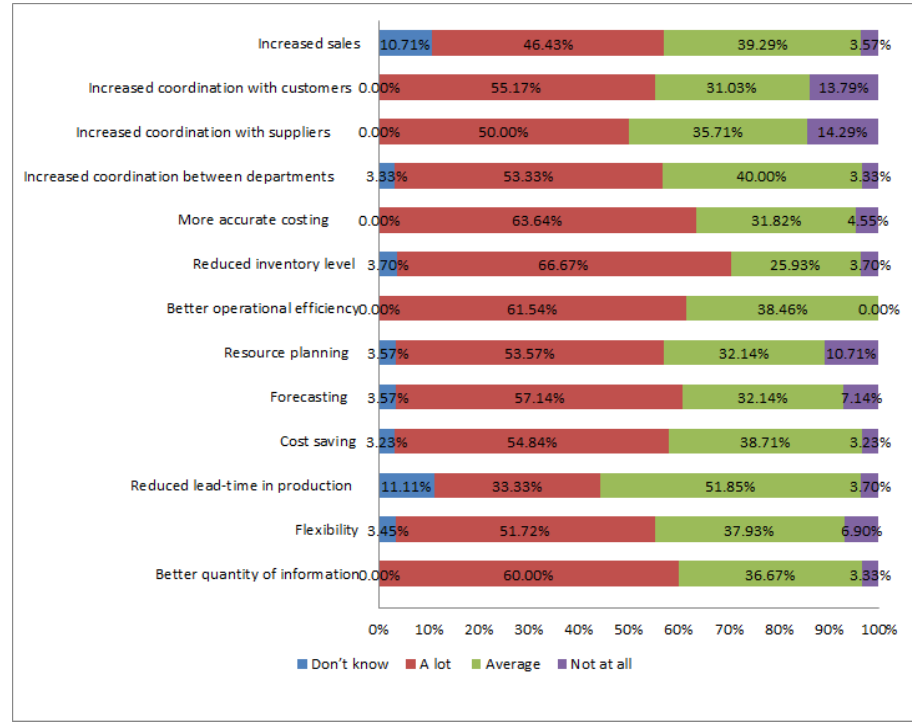
Figure 7. The benefits of using the SCMIS